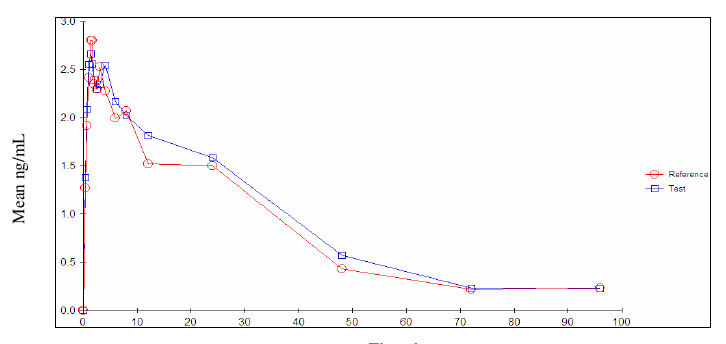
Figure 10. Mean plasma drug concentration –time profile for MHA in healthy volunteers after a single oral dose of 60 mg ALV capsule ( n = 48)